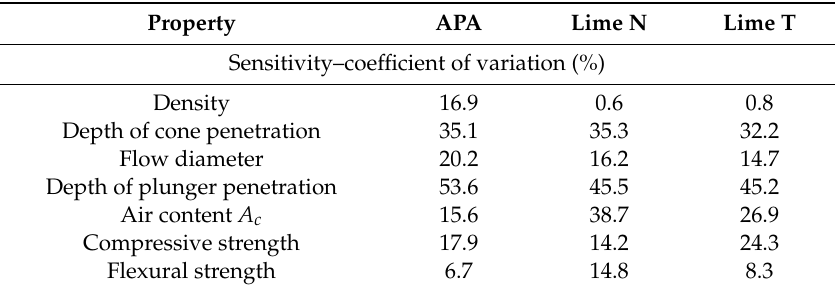
Table 16. The sensitivity of masonry mortars properties to mistakes in dosing